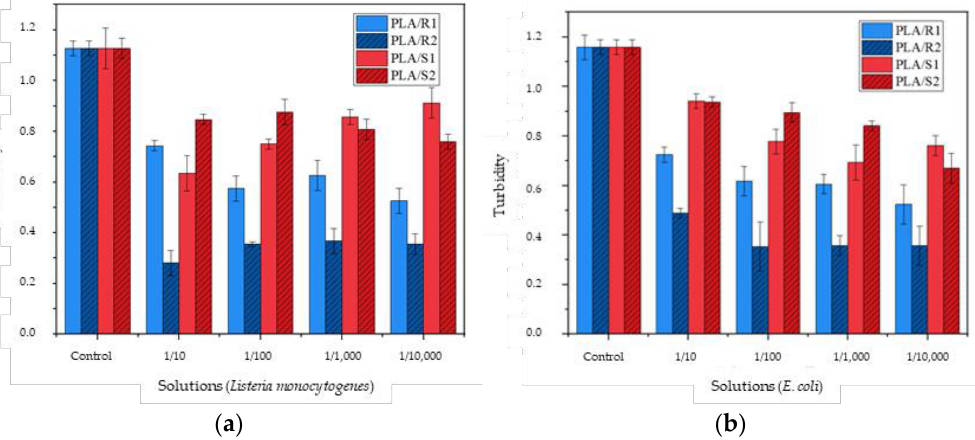
Figure 10. Bacterial efficacy of 3D-printed microtiter pieces for each composite PLA/R1, PLA/R2, PLA/S1 and PLA/S2 ( a ) Listeria monocytogenes ( b ) E. coli. Standard deviation calculated with three replications per test.